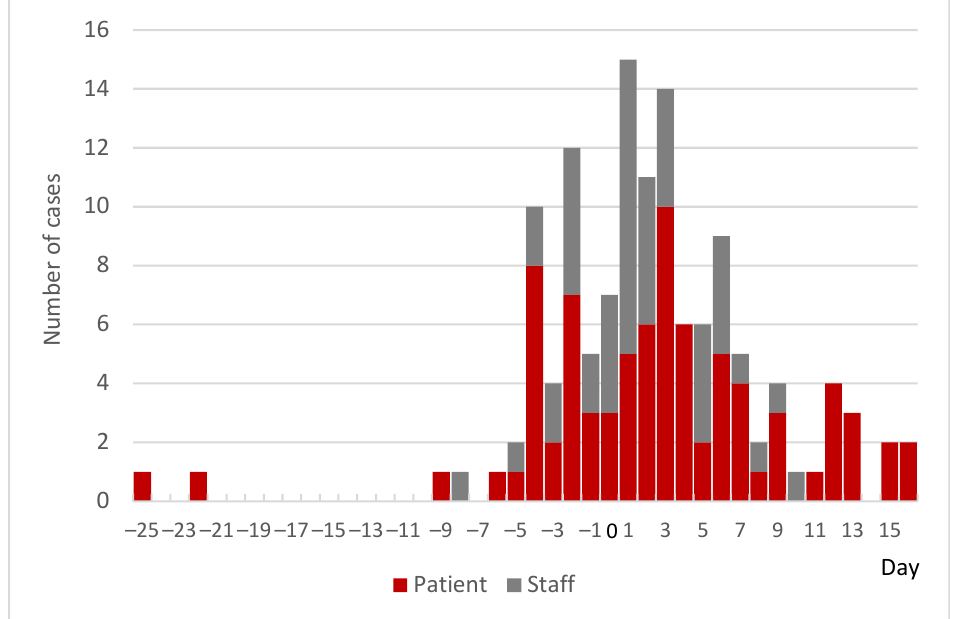
Figure 2. Epi curve of cases with confirmed onset dates and estimated onset dates at Hospital A. Cases confirmed between Day −25 and Day 41 ( n = 130).